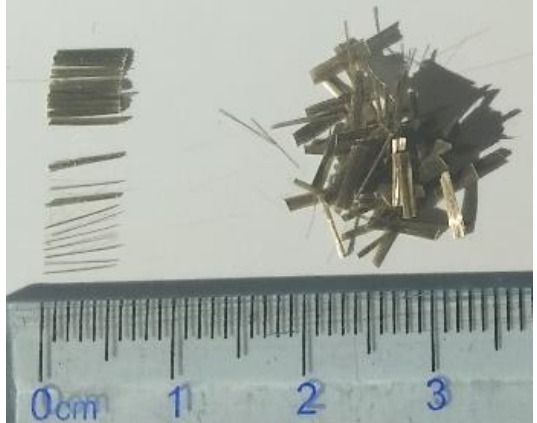
Figure 1. Appearance of basalt fiber.